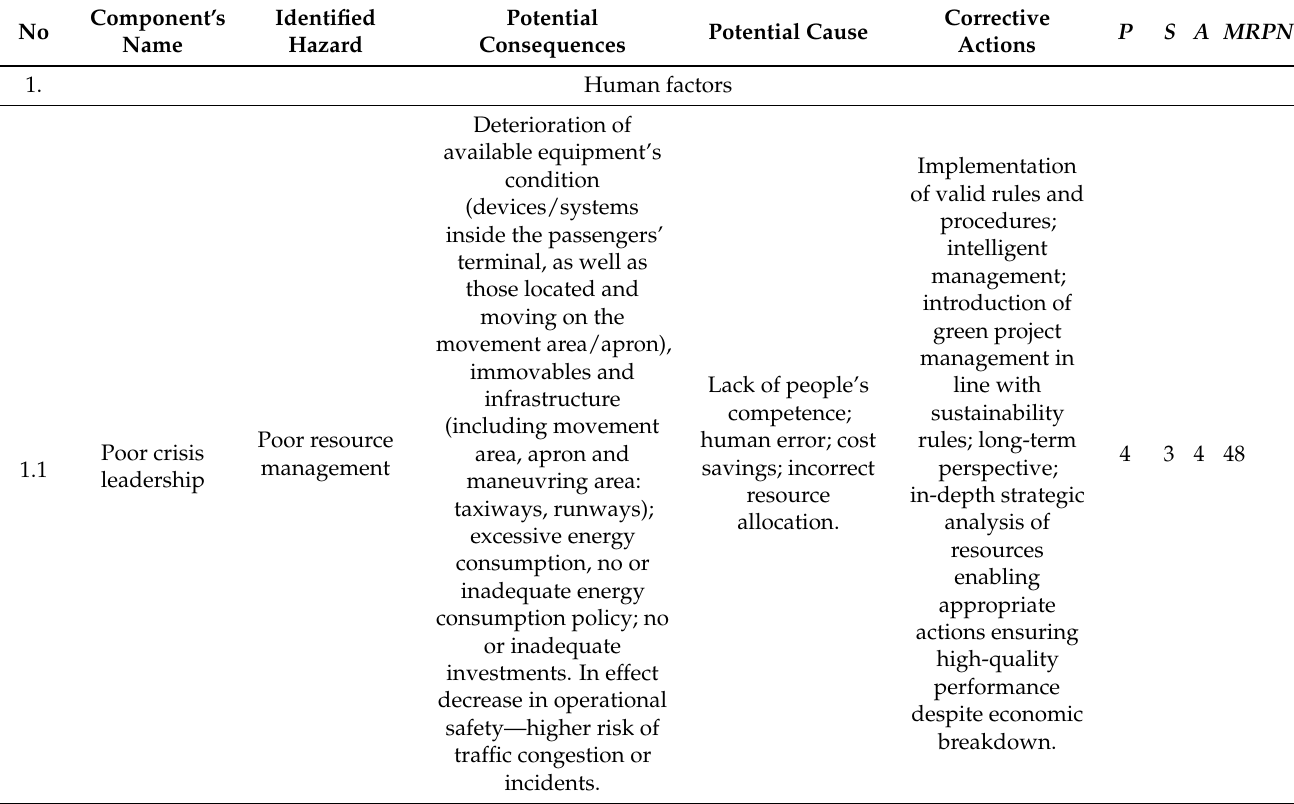
Table 4. Risk assessment concerning the influence of aerodromes’ difficult economic situation on the safety in civil aviation, own